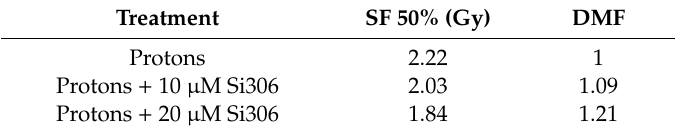
Figure 1. Cell survival curves of U87 cells. Cells treated with protons only (black line), protons plus 10 µ M of Si306 (red line), and protons plus 20 µ M of Si306 (blue line). Table 3. Dose modifying factor (DMF) values calculated as isoe ff ective dose at surviving fraction of